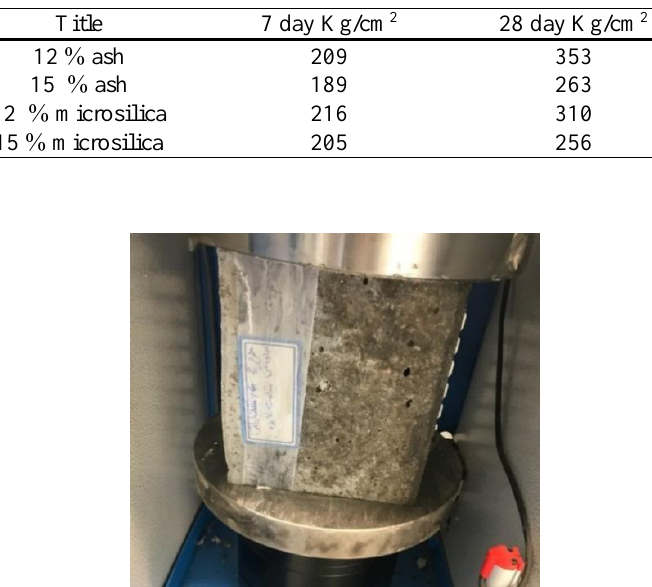
Table 10. Mean compressive strength of samples containing rice husk and microsilica .